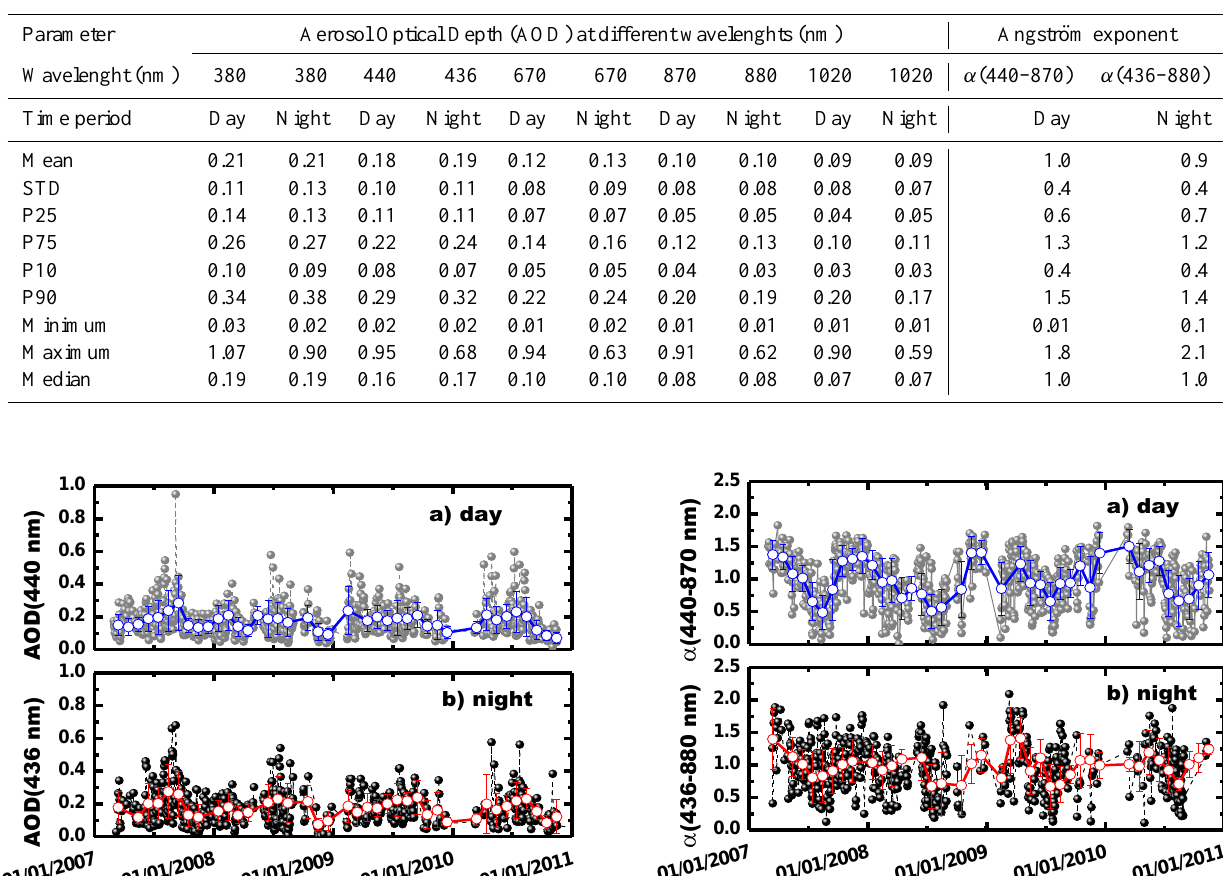
Table 1. Daytime and nighttime spectral aerosol optical depth AOD( λ) and Angstr¨om exponent α statistics for the 4-year data series in the city of Granada; STD is the standard deviation; P10, P25, P75 and P90 are the corresponding percentiles at 10, 25, 75 and 90%.